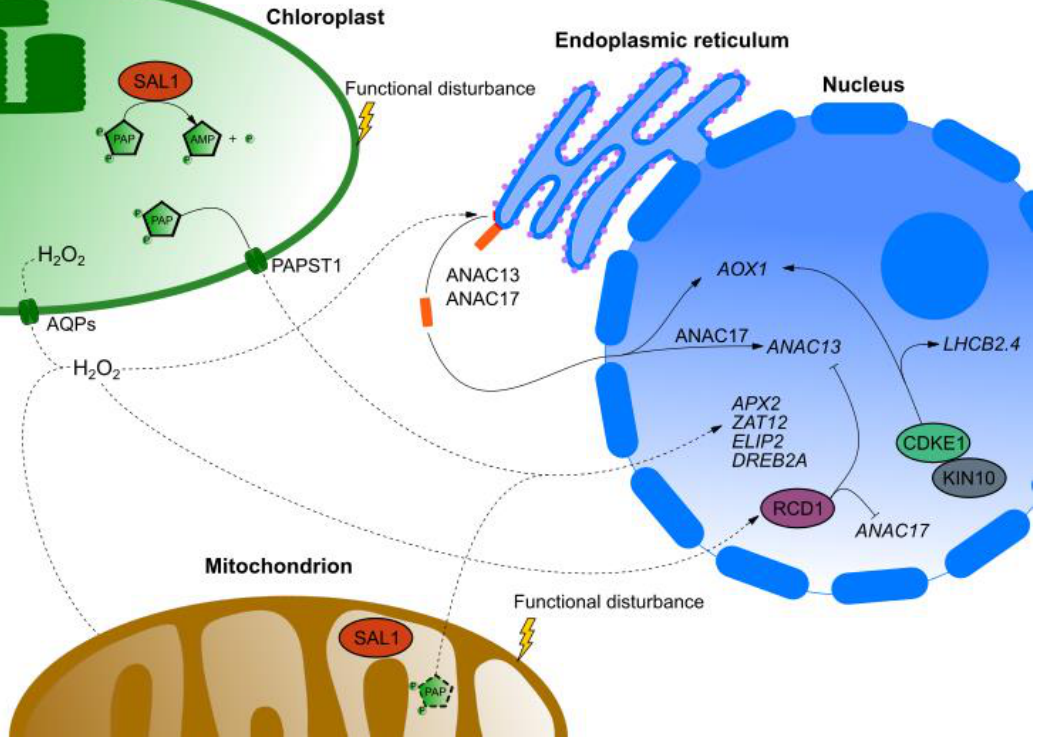
Figure 4. Putative integrators of retrograde-signaling pathways. Inhibition of inositol polyphosphate 1-phosphatase (SAL1) results in accumulation of 3′ -phosphoadenosine 5 ′ -phosphate (PAP) which induces expression of many drought and high light related genes such as APX2 , ZAT12 , ELIP2 and DREB2A . RCD1 after induction with ROS inhibits expression of ANAC13 and ANAC17 which regulates AOX1 expression. CDKE1 induces expression of AOX1 and LHCB2.4 and many other genes as part of mediatory complex regulating RNAPII dependent transcription. Dotted lines represent pathways which lack experimental evidence or exact nature of indicated regulation is still